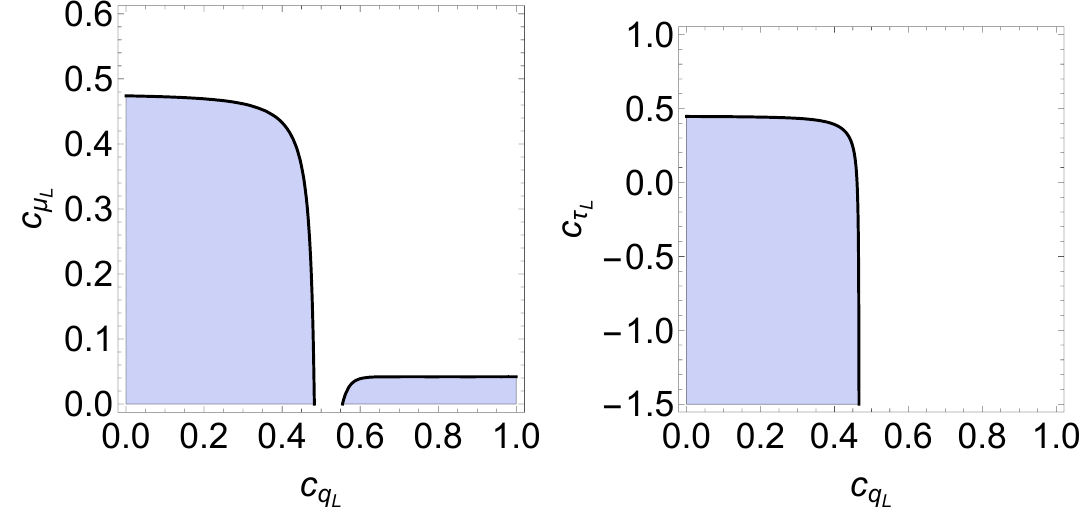
Figure 10 . Exclusion region in the plane ( c q nances decaying into di-muons A (cid:22) < 0 : 003 (left panel), and decaying into di-taus A (cid:28) < 0 : 022 (right panel), for M n = 2 TeV. We have used c q c t = 0 : 45. In the left panel we have considered c (cid:28) R